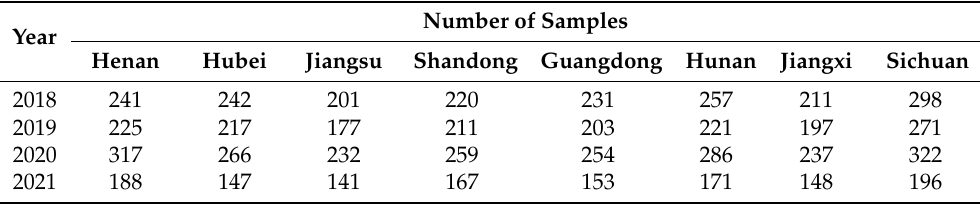
Table 1. The information of the samples collected from each province from 2018 to